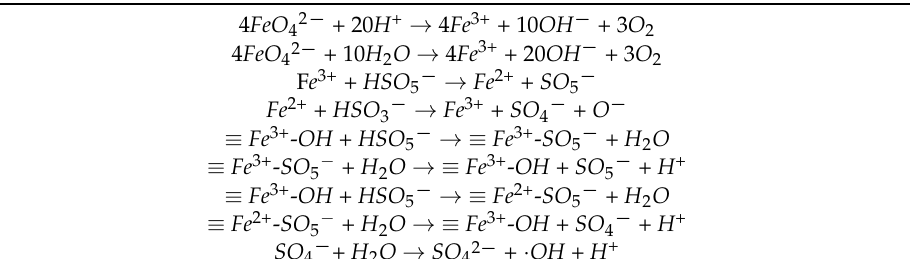
Table 2. Reaction processes involved in the generation of sulpha and hydroxide radicals by the interaction between the ferrate resultant Fe(III)/Fe(II) species and peroxymonosulphate [10,16,17].